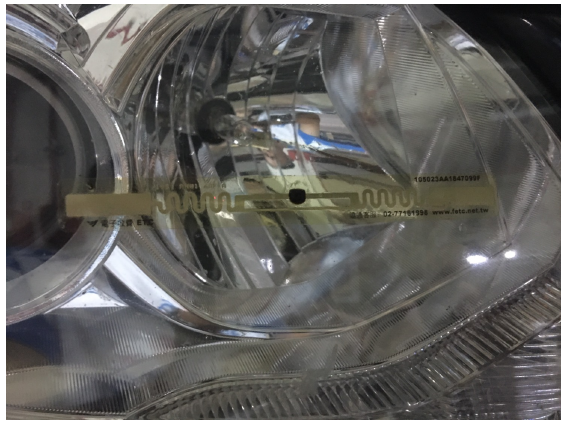
Figure 4. Example: an electronic tag attached on the front light of one car.